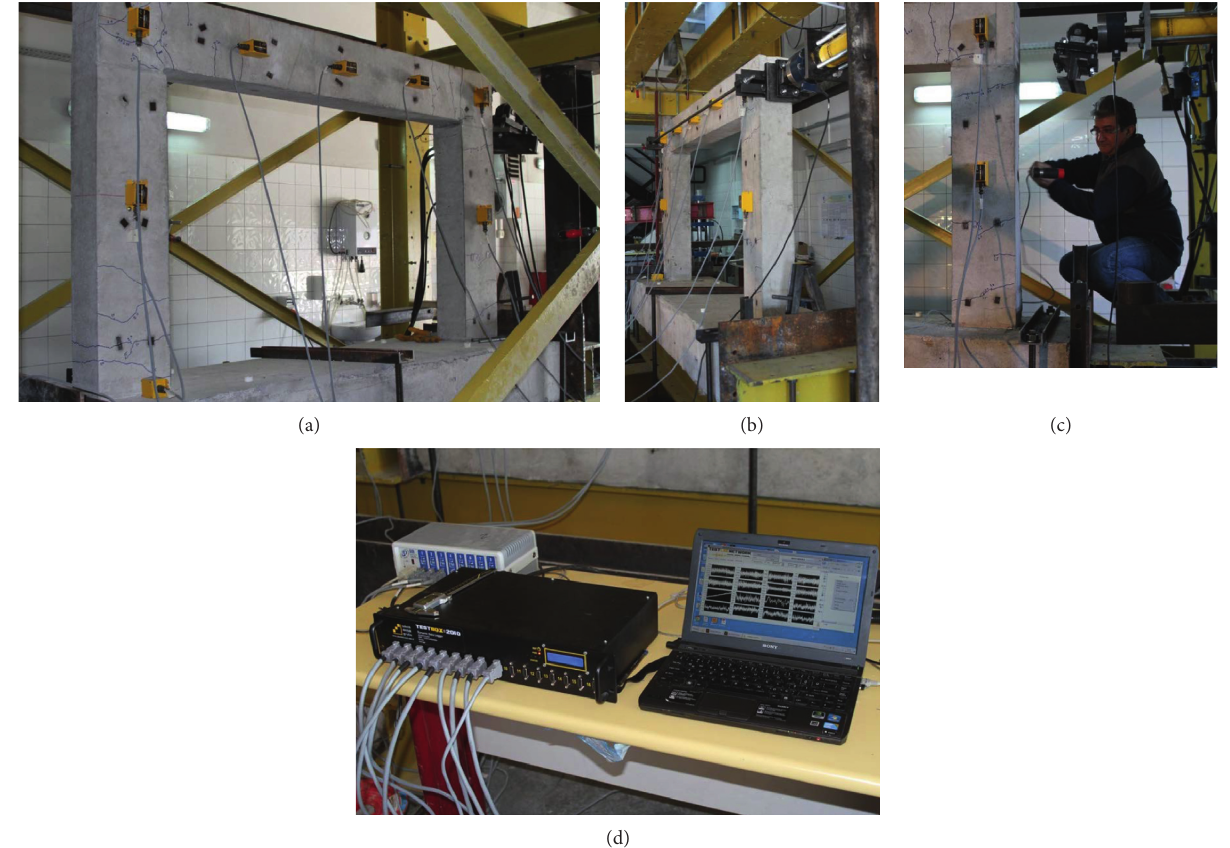
Figure 4: Views of (a) the test frame with accelerometers, (b) the loading system, (c) the impact vibration test, and (d) the data acquisition